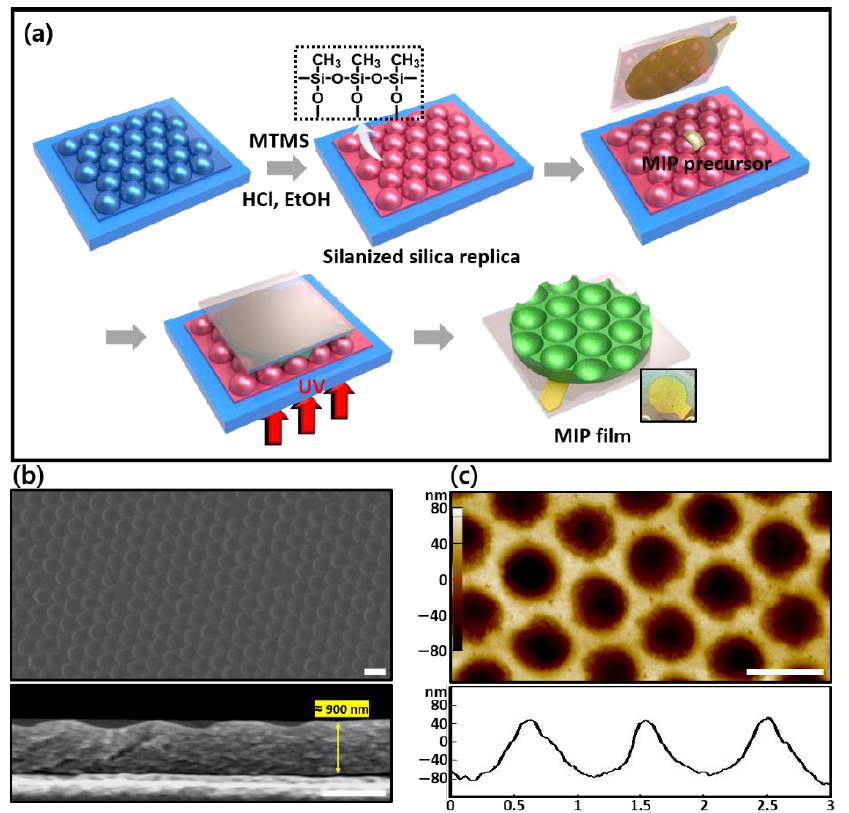
Figure 3. ( a ) Fabrication process of a porous MIP ( st -MIP) film using a hemispherical silica replica as the master mold, ( b ) SEM (below is a cross-sectional image), and ( c ) AFM images (line profilometry is included below the AFM image) of the st -MIP film. The scale bars are 1 μm.